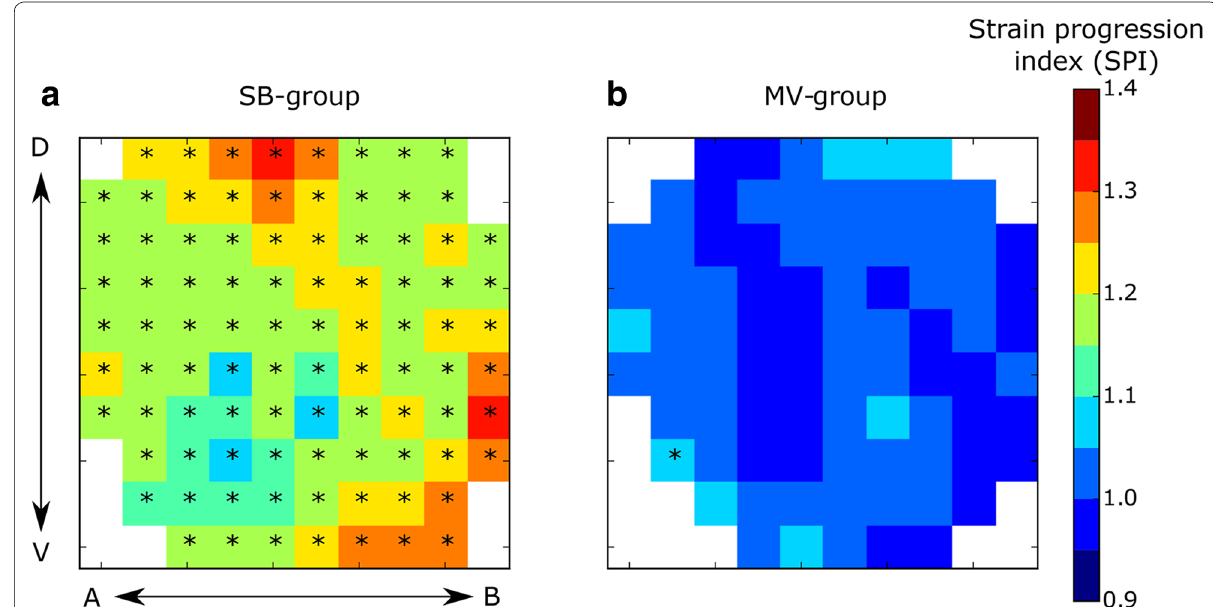
Fig. 3 ROI array maps of the strain progression index (SPI). a SB‑group, b MV‑group. Significant within‑subject differences are denoted by * ( p <